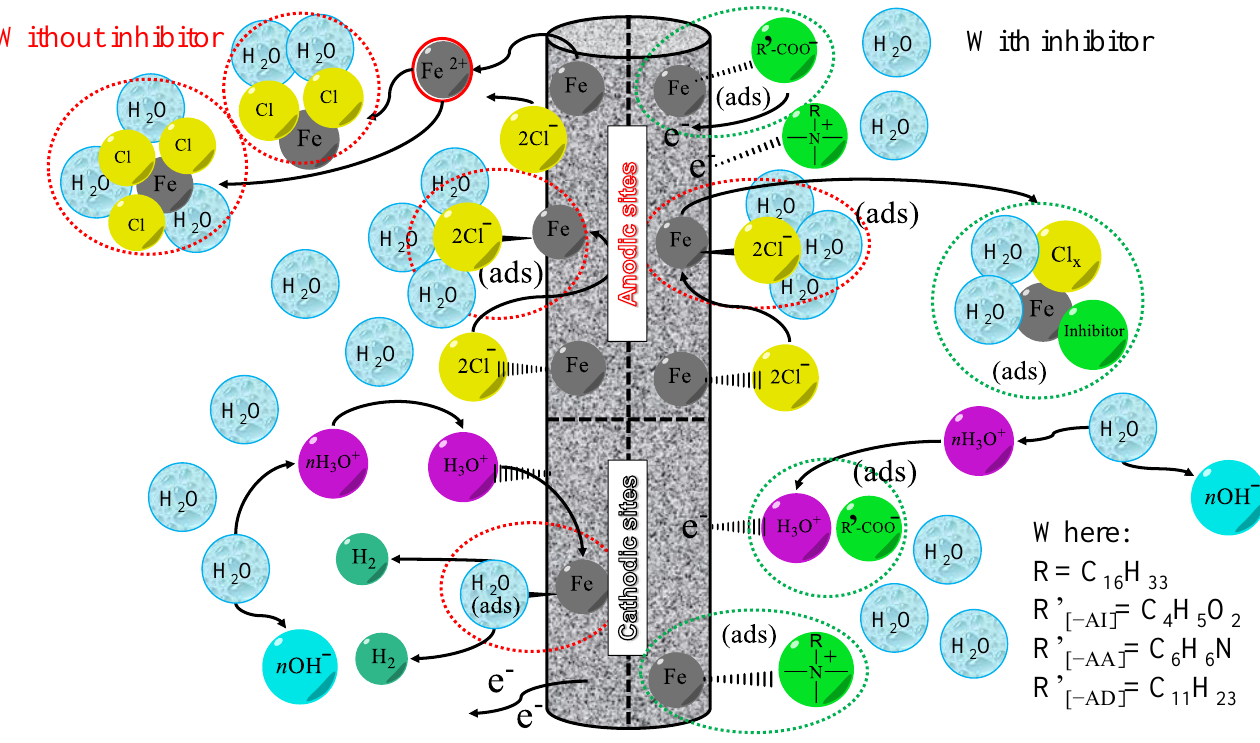
Figure 8. Inhibition mechanism carried out by the ILs evaluated as CIs of API X52 steel in 0.5 M HCl.